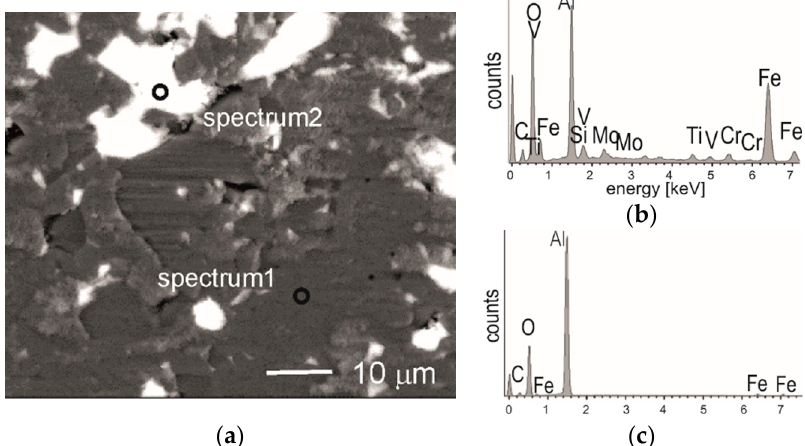
Figure 9. ( a ) Backscattered electron image of worn surface of the alumina ball with marked areas for EDS analysis, ( b ) EDS spectrum 1; ( c ) EDS spectrum 2.